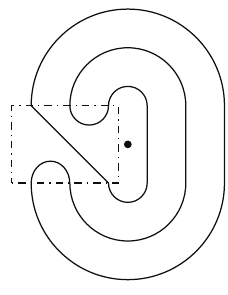
Figure 1: An example of the closure of a crossingless